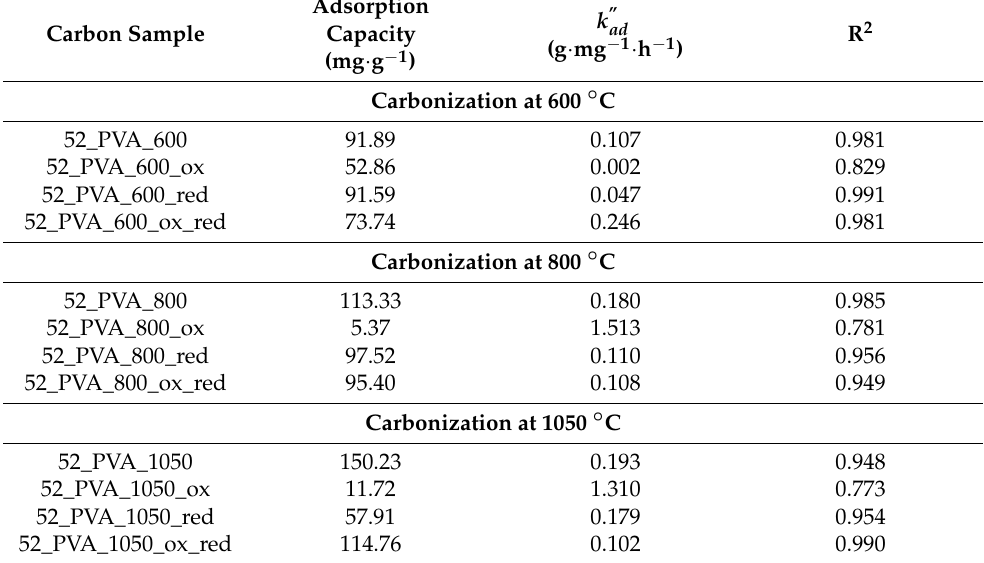
Table 5. Results of fitting the pseudo-second order kinetics model to the experimental data of phenol adsorption on the resol resin-derived carbon materials carbonized at different temperatures and subsequently modified in an oxidizing/reducing atmosphere. Adsorption Carbon Sample Capacity (mg · g − 1 ) Carbonization at 600 ◦